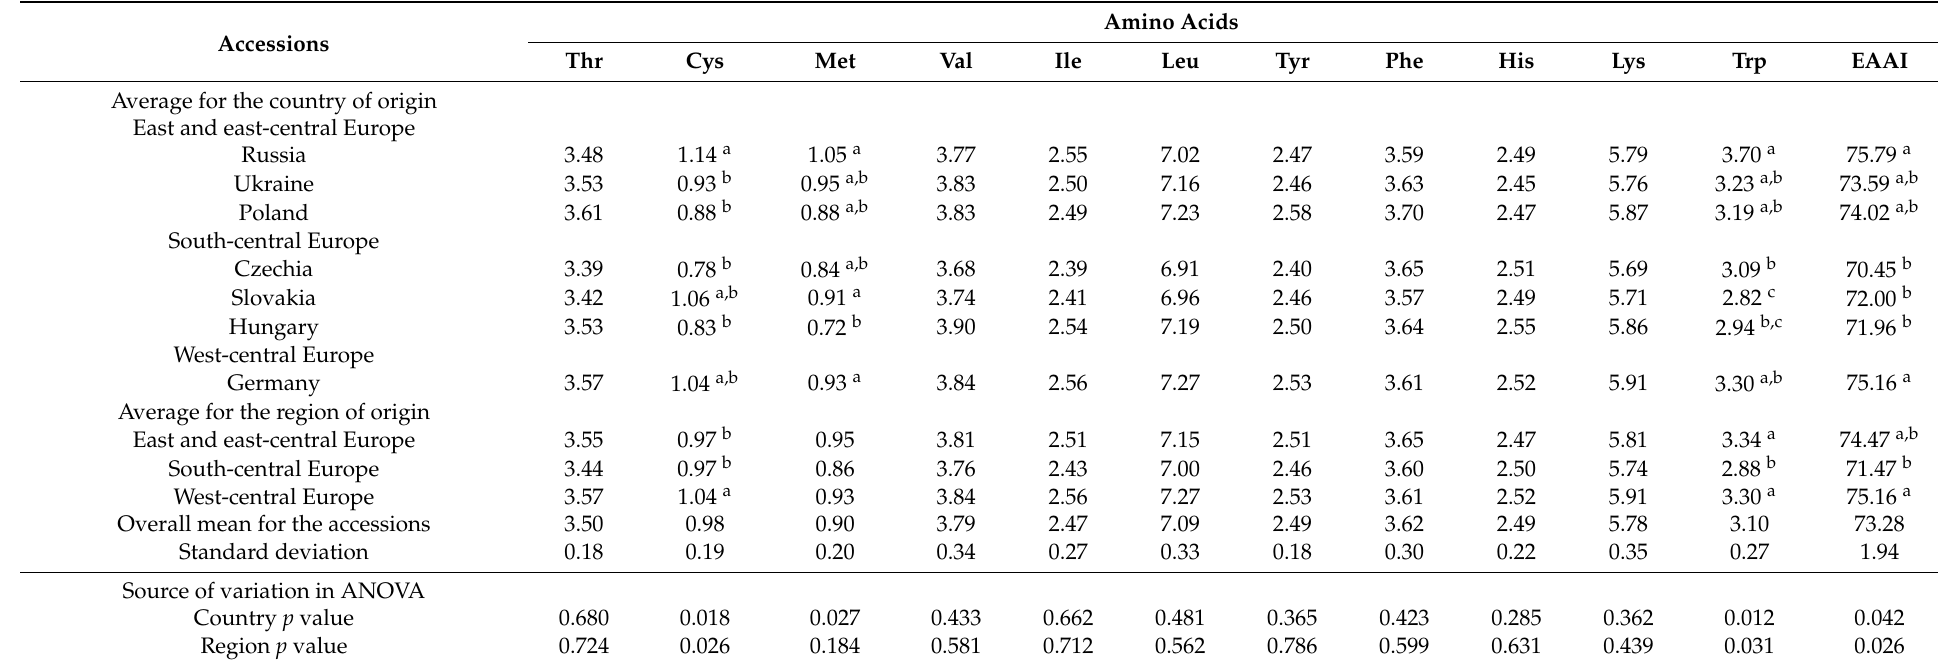
Table 3. Average essential amino acid content (g 100 g − 1 of crude protein) in Vicia sativa